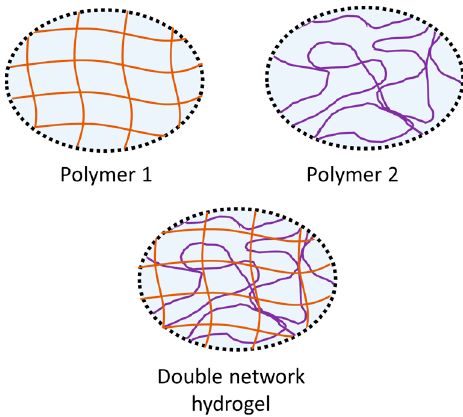
Figure 3. Double network hydrogels consist of a rigid polymer with a high crosslinking density for high strength. This polymer is independantly polymerised from the second polymer that is interpenetrated and crosslinked at a lower density for flexability.